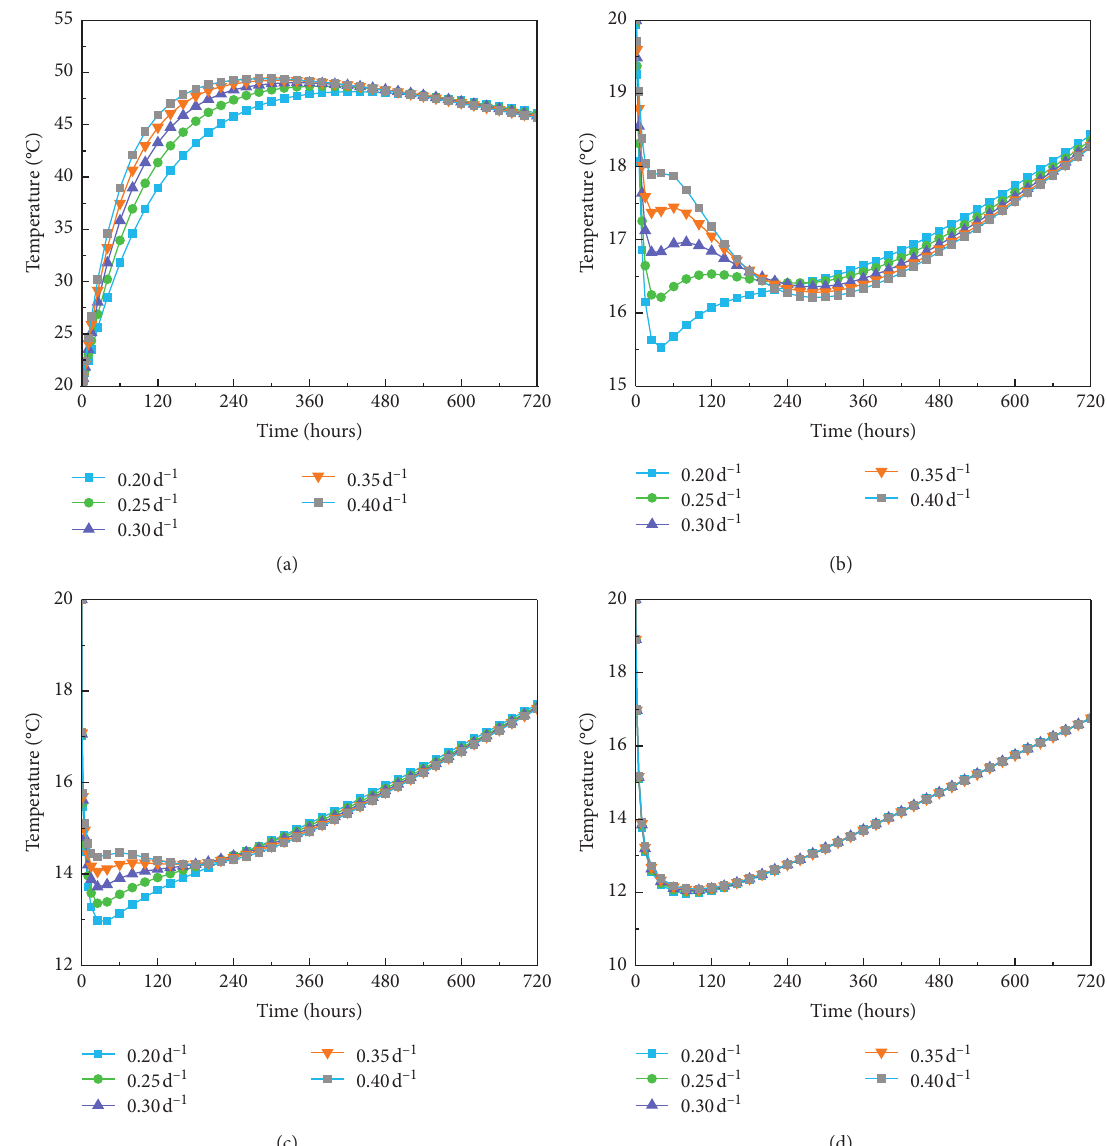
Figure 10: Temperature-time curves with different temperature rise coefficients. (a) Point A, (b) point B, (c) point C, and (d) point